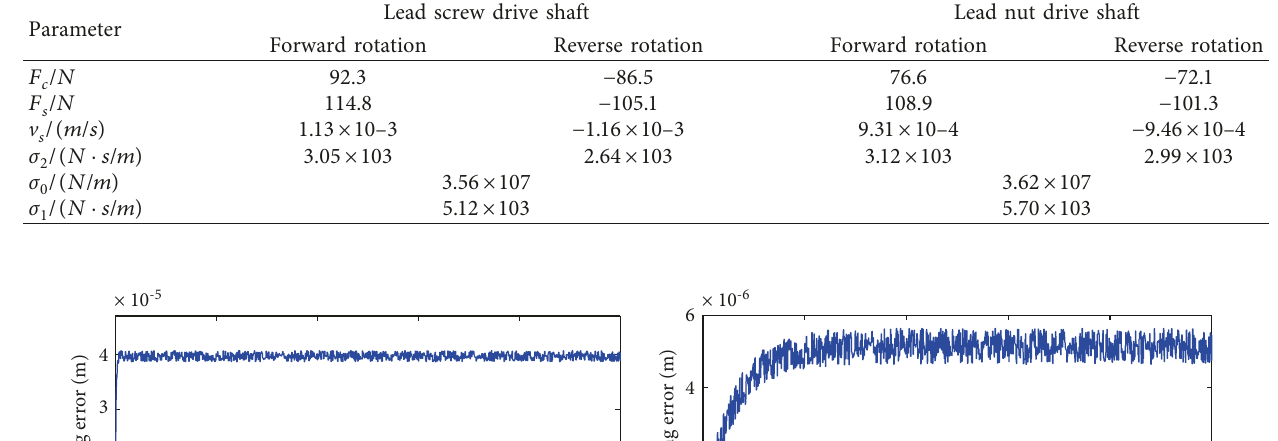
Table 1: Friction model parameters of two-axis differential microfeed system.